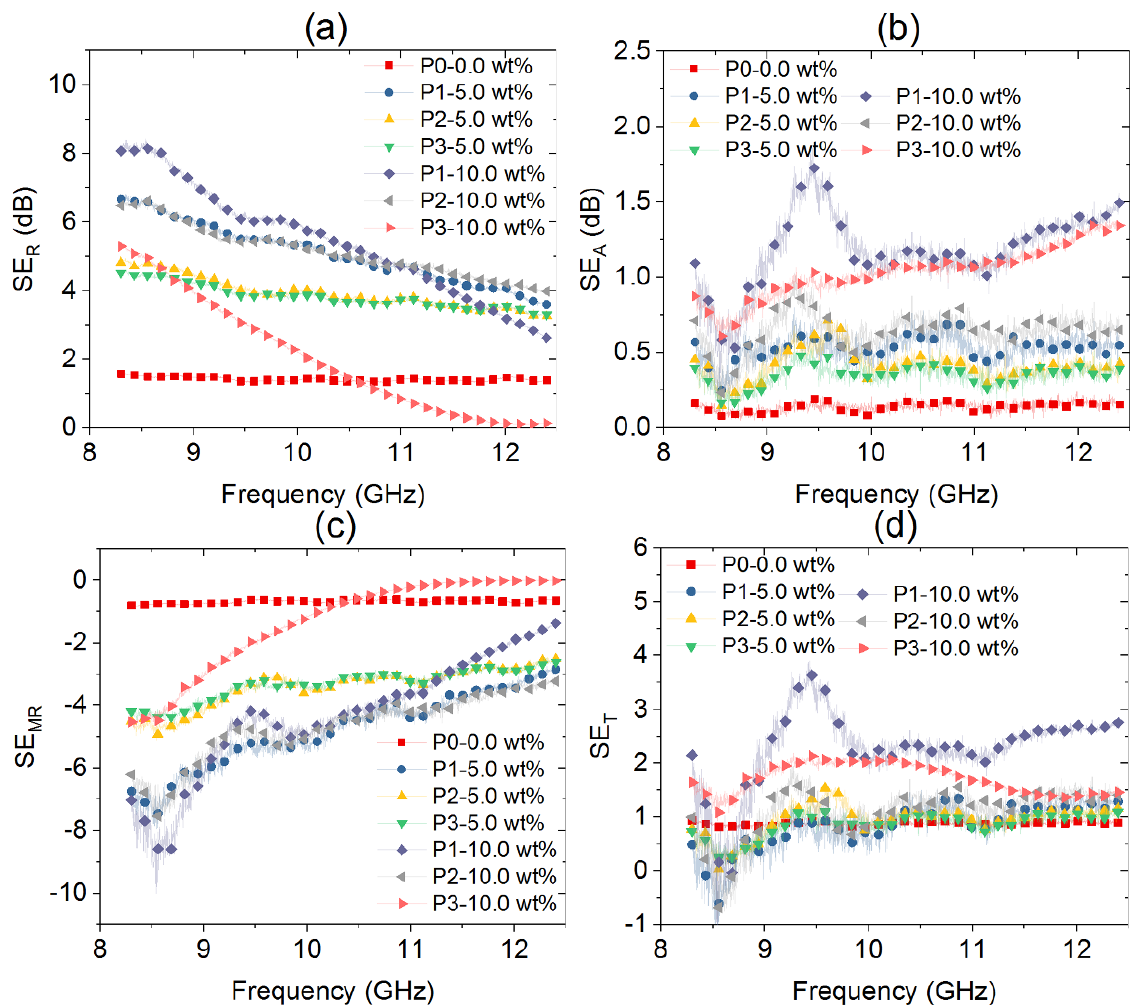
Figure 6: SE of the polymer composites in 5.0 and 10.0 wt% of NGF. (a) SE R , (b) SE A , (c) SE MR , and (d) SE T